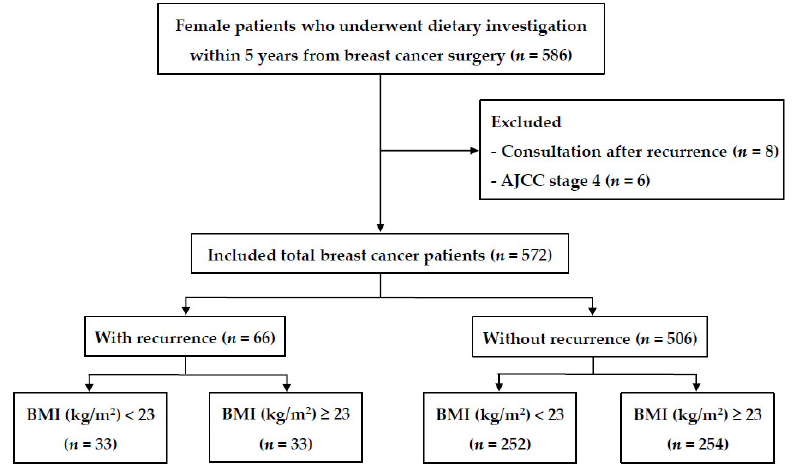
Figure 1. Flowchart of the study patient selection process. AJCC, American Joint Committee on Cancer; BMI, body mass index.